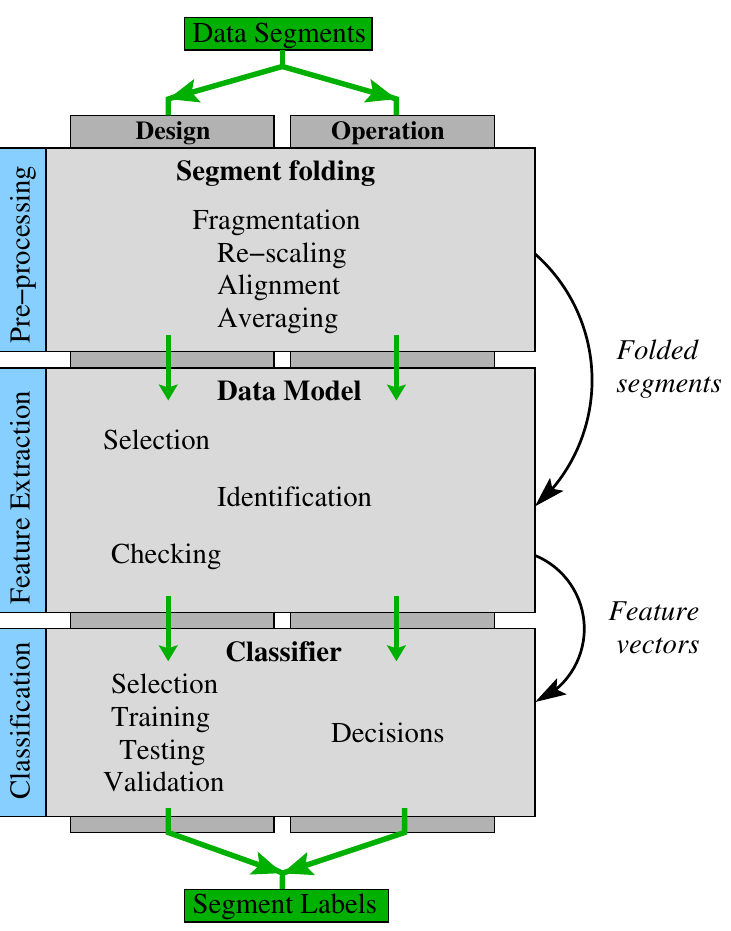
Figure 2. A procedure for efficient classification of near-cyclostationary signal segments employing segment folding as the first pre-processing